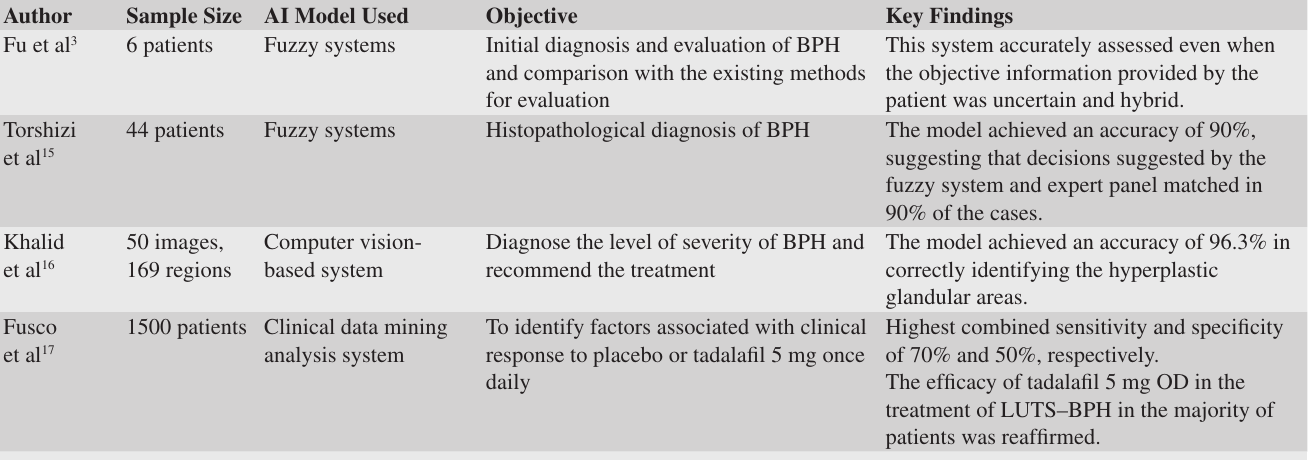
Table 1. Summary of Studies Looking at Applications of AI in Benign Prostatic